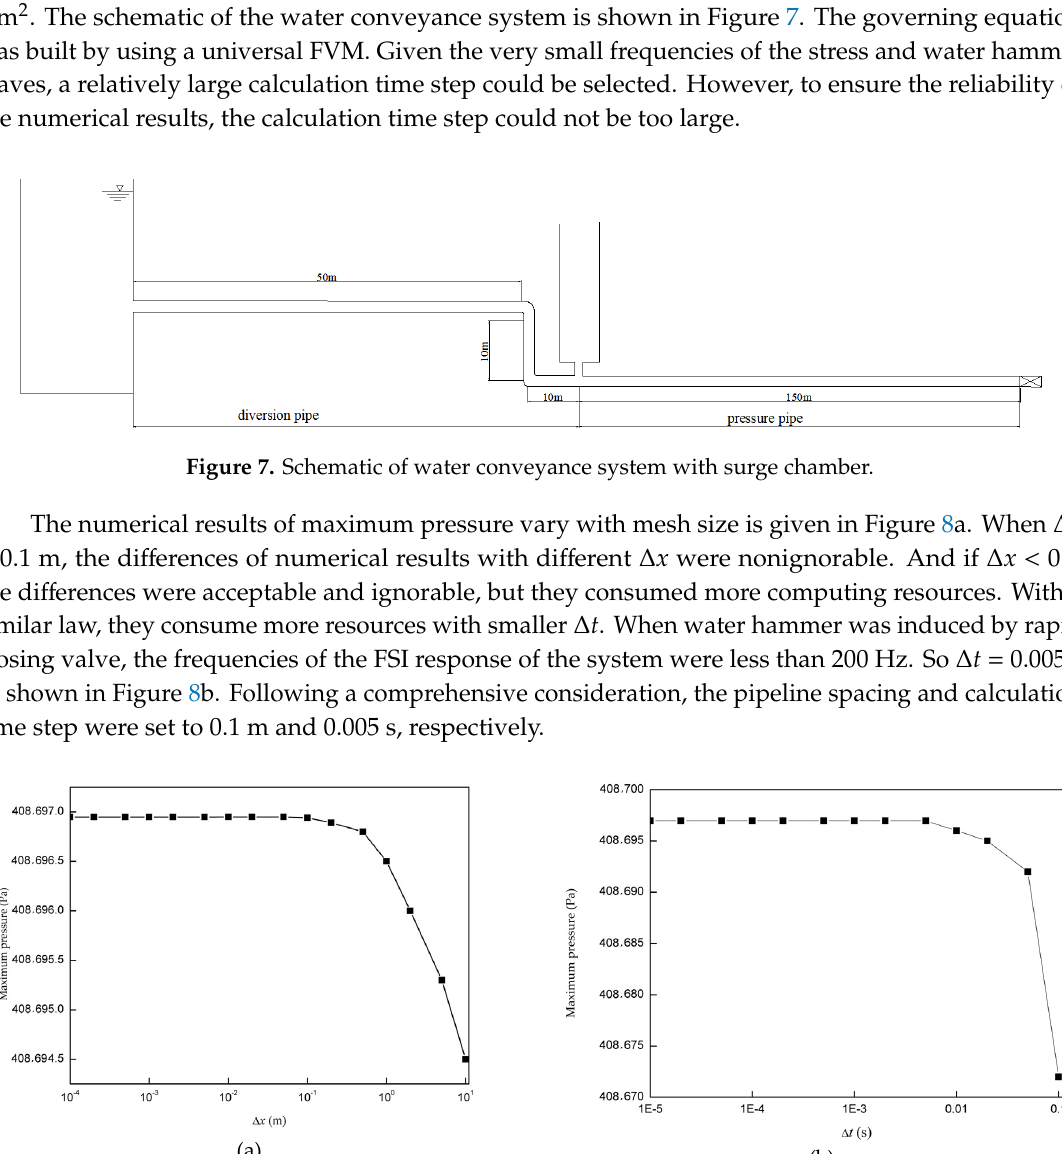
Figure 9. Time history of flow velocity near surge chamber, ( a ) upstream, ( b ) downstream.